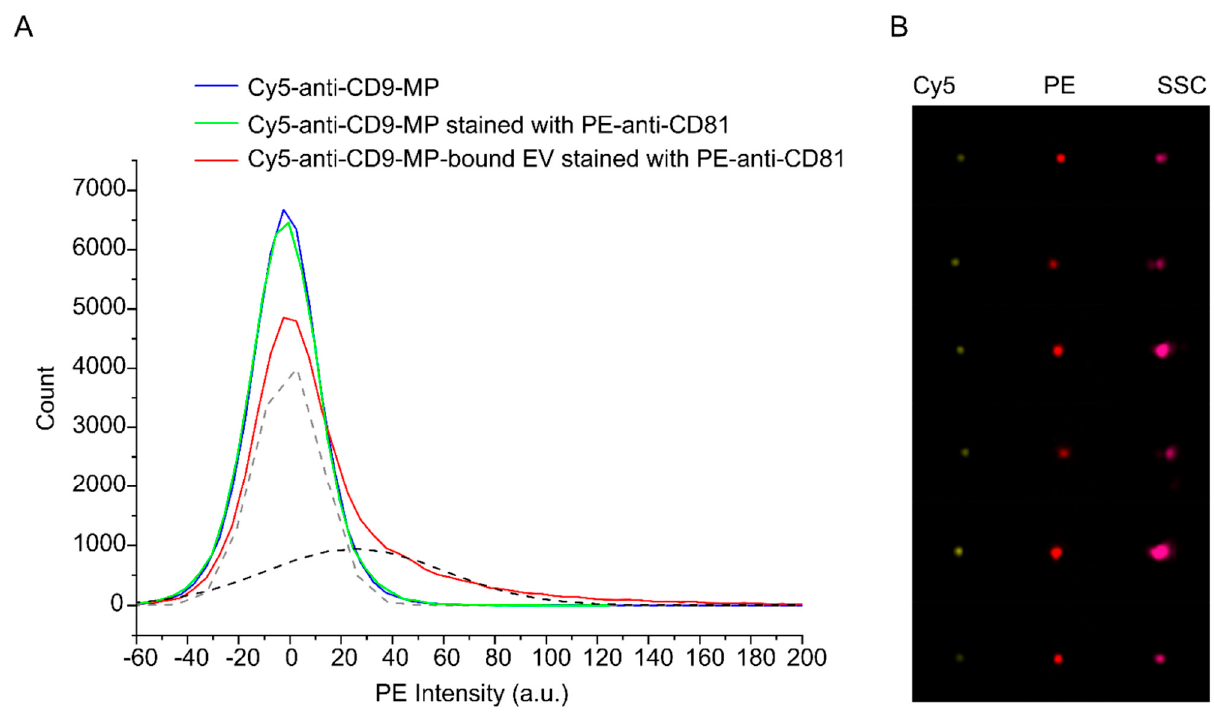
Figure 3. Analysis of binding of PE-anti-CD81-stained HT29 EVs to Cy5-anti-CD9-MP with imaging flow cytometry. ( A ) PE intensity histograms. Fitting of the histogram of the Cy5-anti-CD9-MP-bound EVs stained with PE-anti-CD81 with two Gaussian distributions are shown by dashed lines (grey—unbound Cy5-Anti-CD9-MP; black—EV–Cy5-Anti-CD9-MP immune complexes). ( B ) Representative images of the formed immune complexes between Cy5-anti-CD9-MP and PE-anti-CD81-labelled EVs in Cy5, PE, and side scatter (SSC) channels.